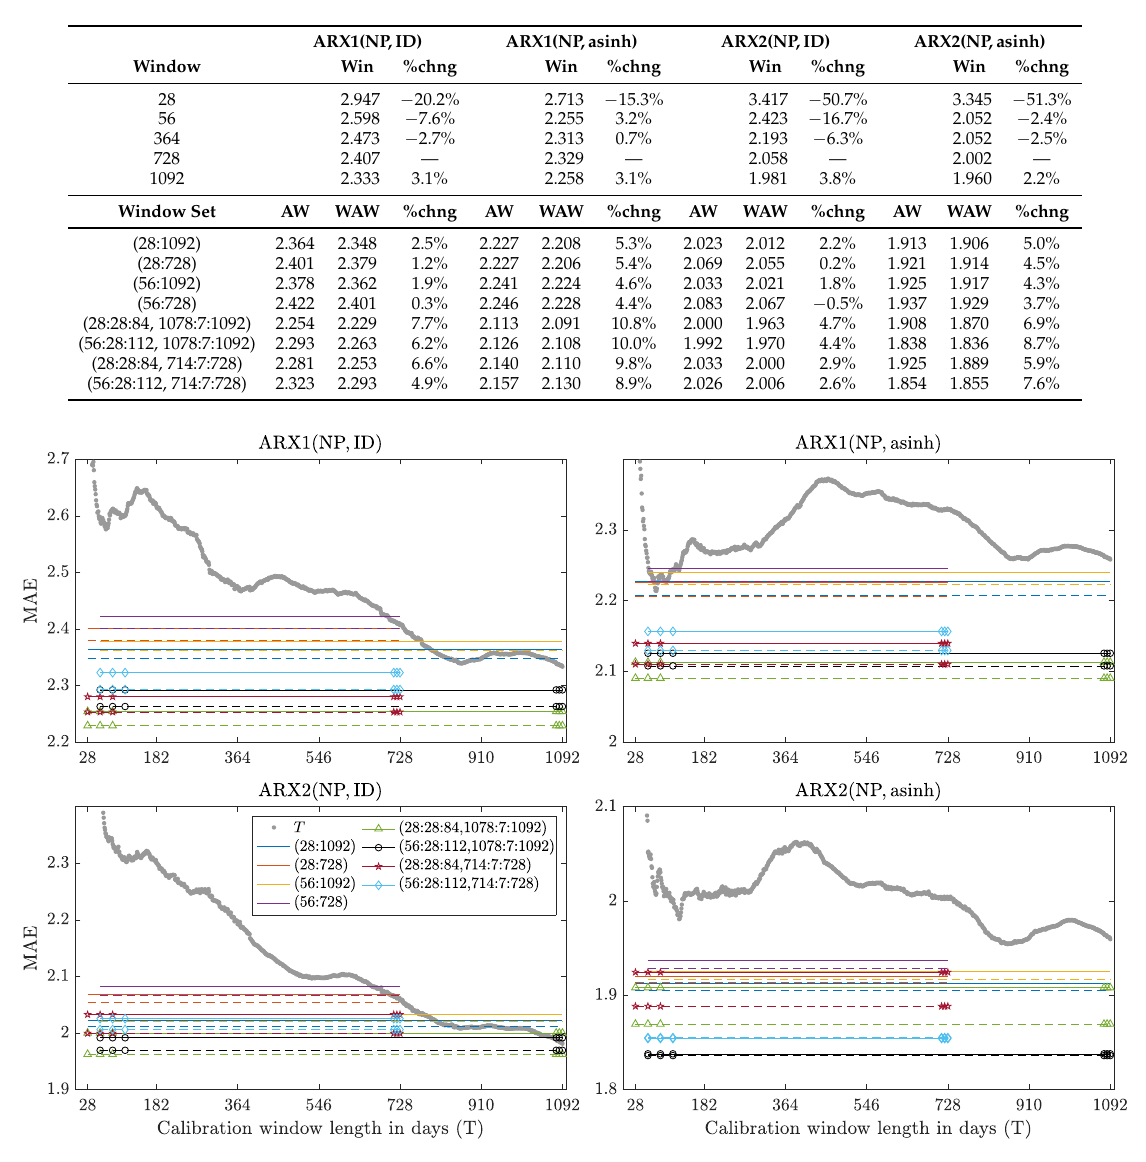
Figure 4. Mean absolute errors (MAE) for the Nord Pool (NP) dataset as a function of the window length T = 28,...,1092 (gray circles) and obtained by combining forecasts: solid lines for AW ( T ) and dashed lines for WAW ( T ) averages across all windows in a given range, solid lines with symbols for AW ( T ) and dashed lines with symbols for WAW ( T ) averages with cherry-picked windows. MAEs are plotted for ARX1 ( top ) and ARX2 models ( bottom ), calibrated to raw ( left ) and asinh -transformed prices ( right ). Note the different scales. Out-of-range lines or symbols are not